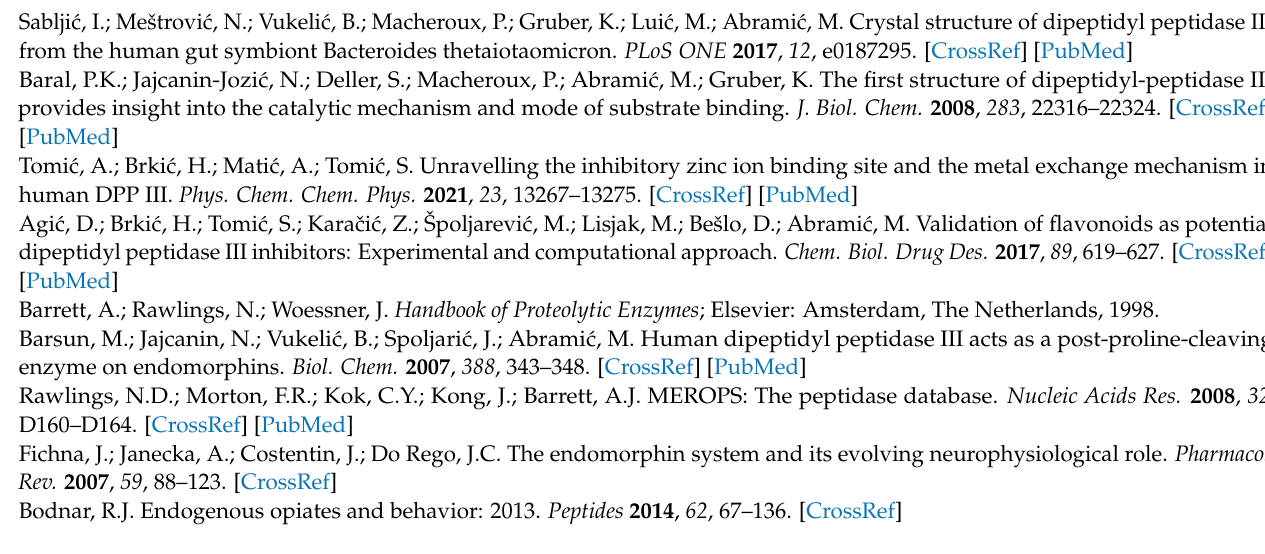
yellow lines. Figure S3: RMSD values and the aligned average structures of three systems during 500 ns MD simulations. Figure S4: RMSF plots of three systems. Table S1: Residues contained in each subsite. Table S2: The probability of secondary structures of residue Arg421-Lys423 in three